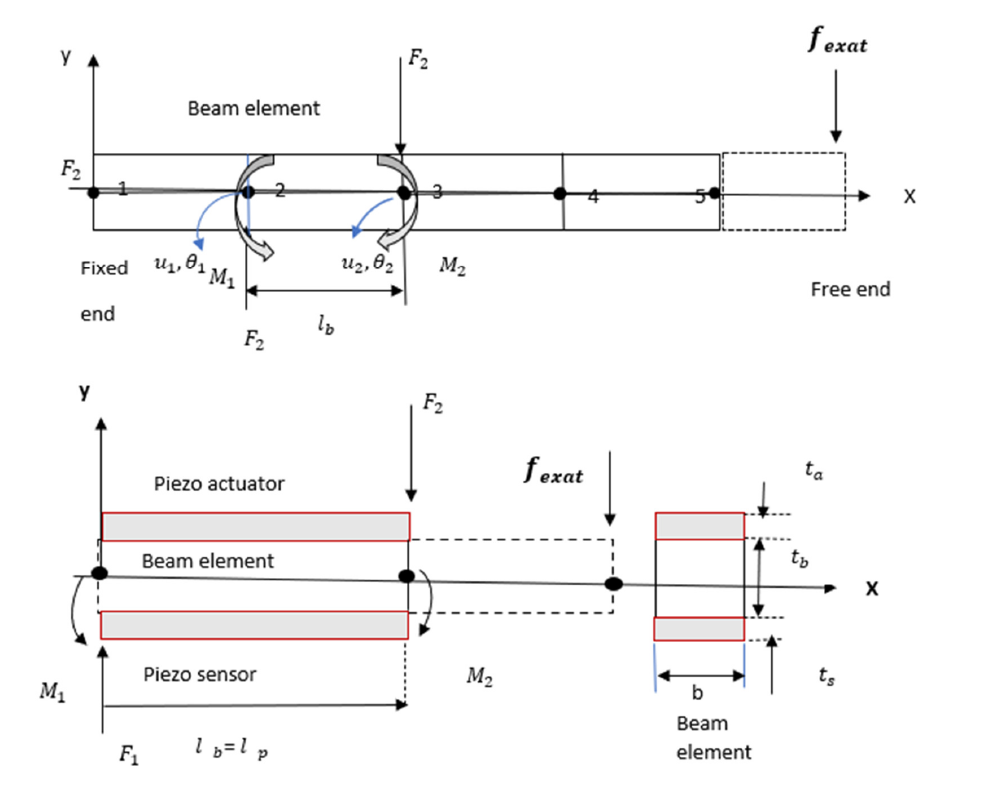
Fig. 1. Smart flexible beam bonded with piezoelectric as (sensor/actuator) divided into 4 finite element. The dynamic equation of sensor output of the smart manipulator which is comprise regular